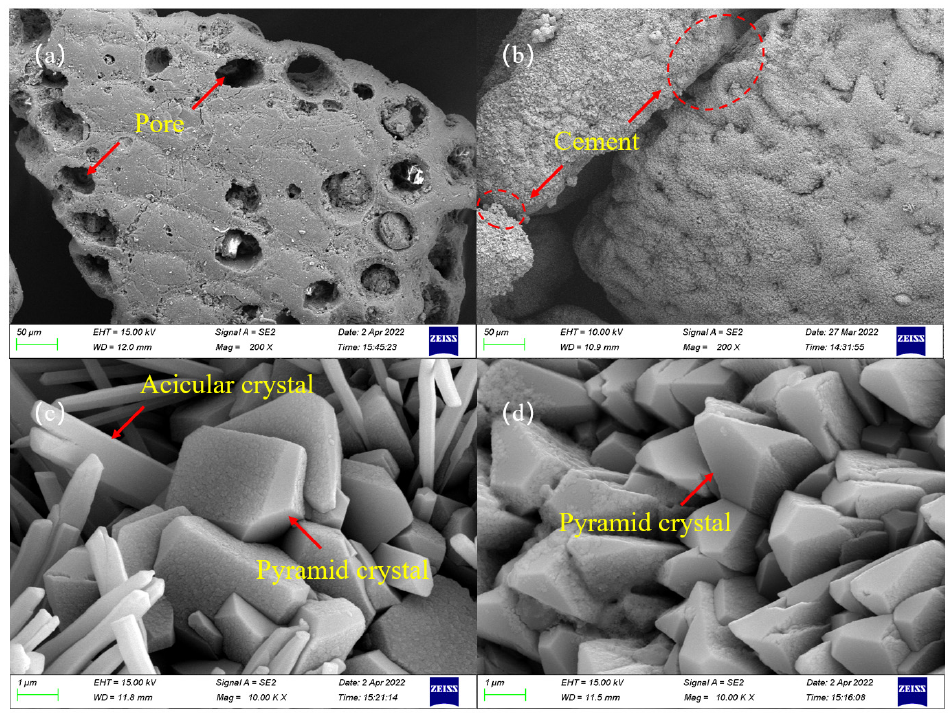
Figure 13. SEM of samples: ( a – d ) are the results of untreated sand, C2, C2, and G4 samples, respectively.